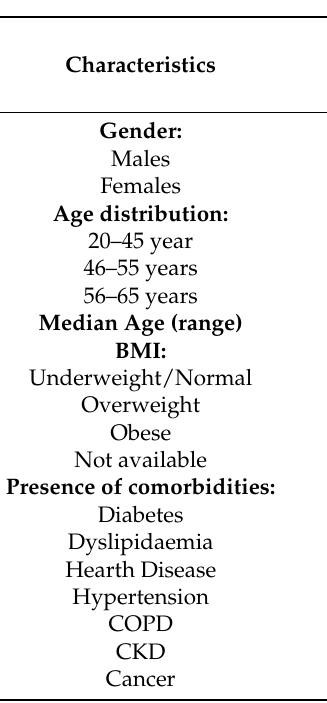
Table 1. Baseline characteristics of patients included in the study stratified by